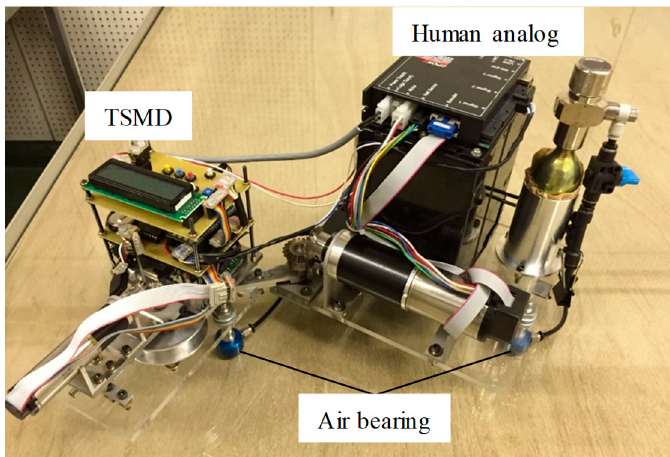
Figure 7. Experimental equipment of the TSMD.